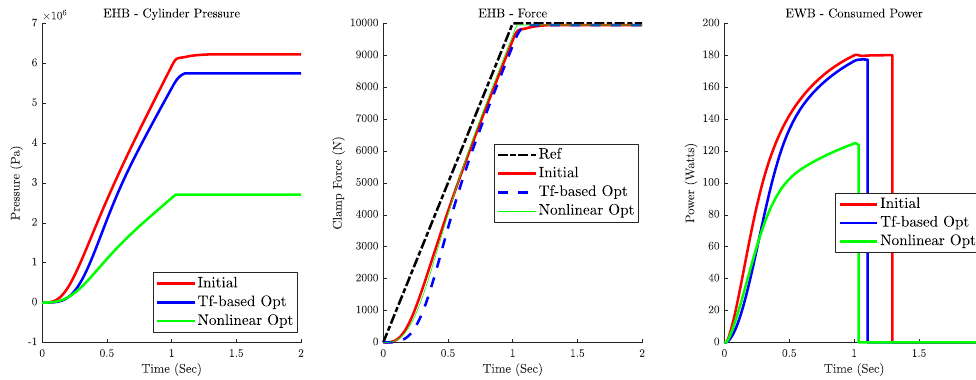
Figure 11. Comparison of the initial parameter sets vs. optimized in an EHB for a ramp input.